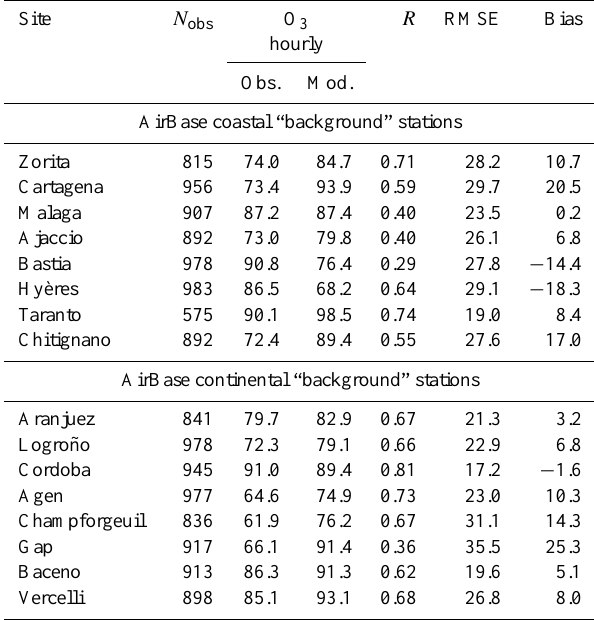
Table 7. R , RMSE and bias of measured and modeled of hourly surface O 3 concentrations (µgm − 3 ), for AirBase